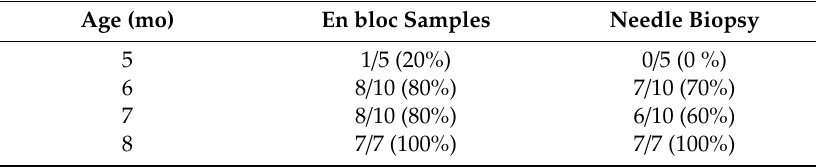
Table 5. Descriptive analysis of the distribution of the tubules with ES within the en bloc samples (n = 192) and within the needle biopsies (n = 32) as a proportion of the total number of animals per age group measured in HE